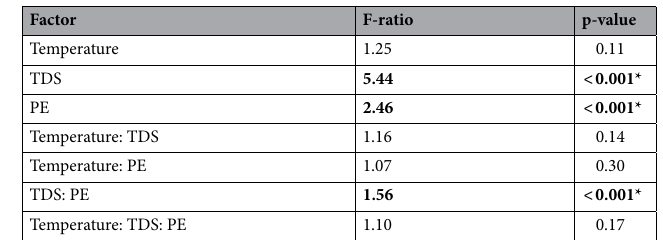
Table 2. Table of select F-ratios and p values from multivariate analysis of variance of independent factors affecting sensory attributes, bolded with asterisks to indicate statistical significance with p < 0.05. For complete MANOVA details, see Supplementary Table S2; for univariate 5 way ANOVA, see Supplementary Table S3; and for pseudomixed ANOVA, see Supplementary Table